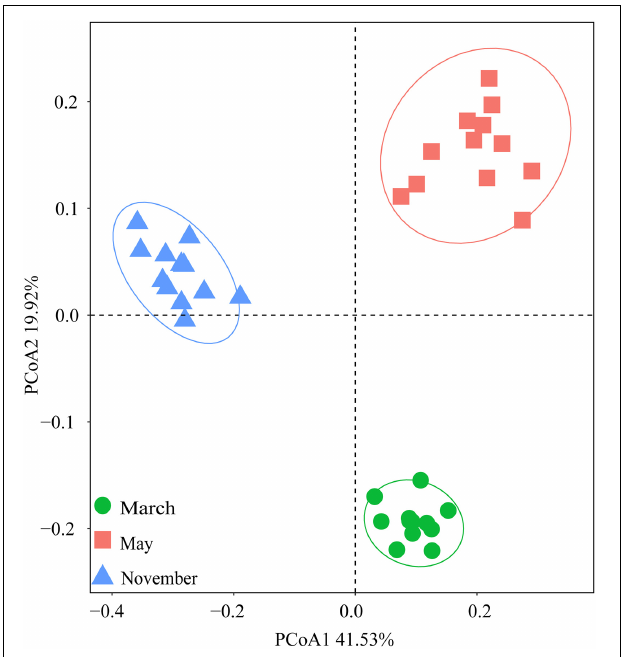
FIGURE 5 | Redundancy analysis (RDA) for the soil bacterial community structure (based on phyla level data, only top 10 phyla are shown in the figure) and environmental variables at different N levels and sampling periods. Only the environmental variables significantly correlated with RDA are shown in the figure. Significance levels are denoted with * p < 0.05, ** p < 0.01, and *** p <